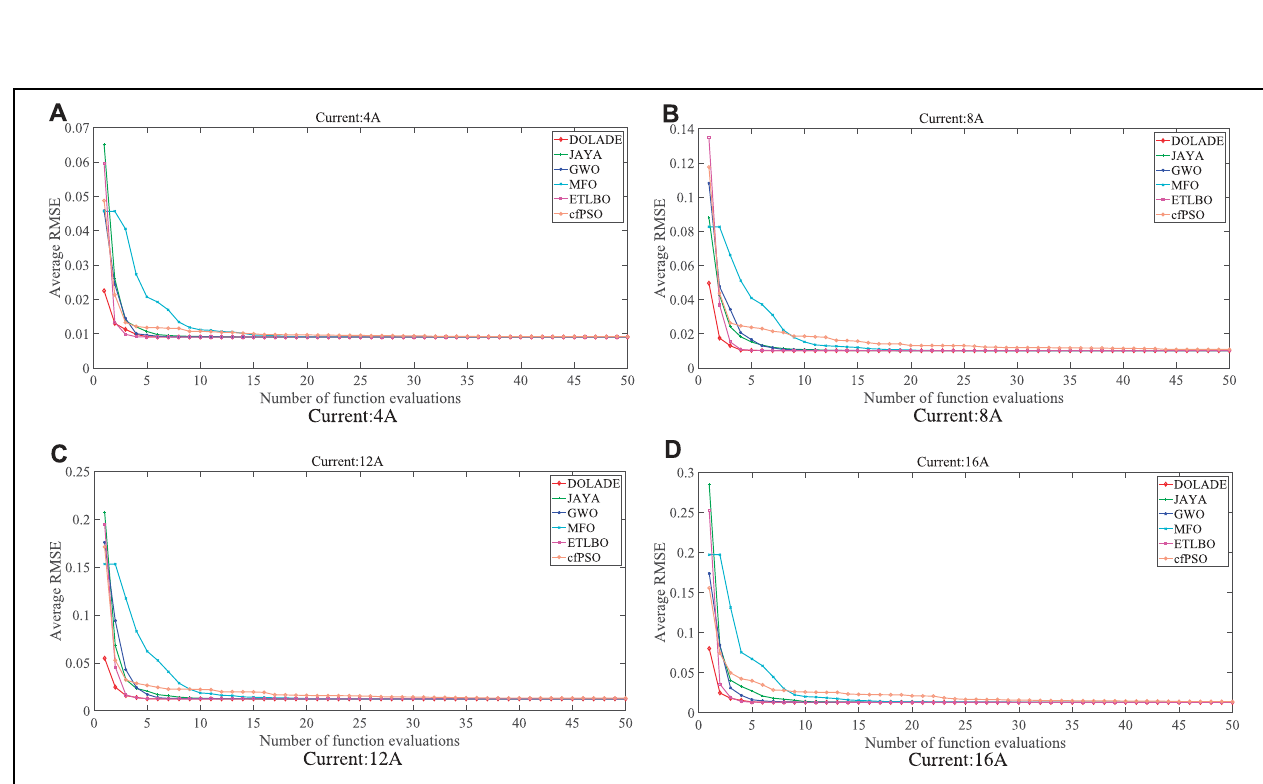
FIGURE 9 | Convergence curves of six algorithms under different